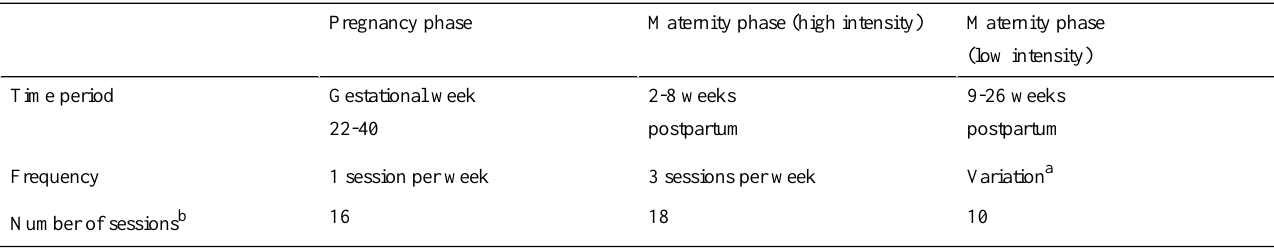
Table 1. Overview of the online-sessions of Mamma Mia across program phase.